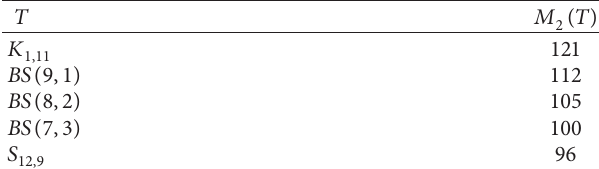
Table 2: Second Zagreb index for trees of order 12. T M K 1 ,